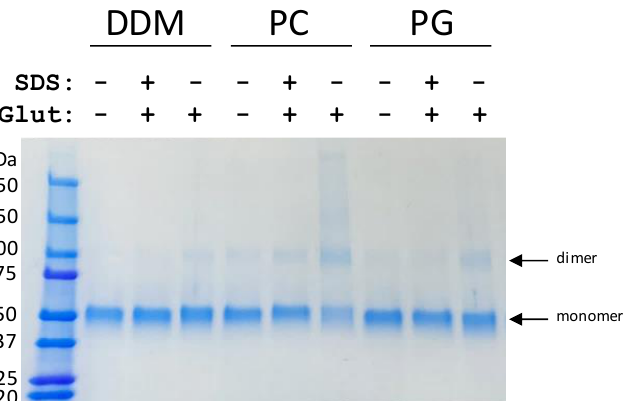
Figure 2. Cross-linking shows lipid-promoted dimerization of ScBor1p. It is indicated above each lane whether the sample is in DDM or reconstituted with PC or PG lipid. “SDS” indicates a 5-min pre-treatment of 2% sodium dodecyl sulfate before the addition of 0.15% glutaraldehyde for 5